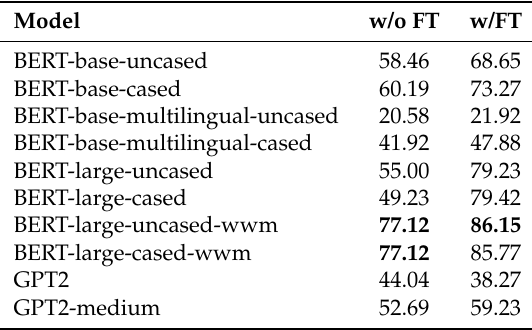
Table 5. Accuracy results (%) of transformer-based models for the MSR test set with and without fine-tuning, which are presented in w/o FT and w/FT columns,